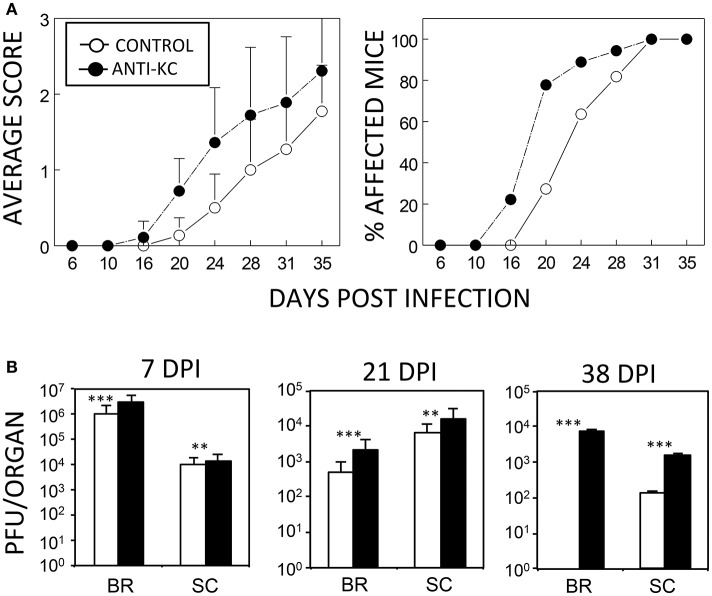
Development of TMEV-induced demyelinating disease in mice treated with anti-KC antibodies or control IgG. (A) Polyclonal rabbit anti-KC antibody or normal rabbit IgG (200 μg/mouse) was intraperitoneally administered into SJL mice (n = 18 and n = 11, respectively) at −1, 2, and 6 dpi with TMEV (1 × 106 pfu/mouse). The infected mice were graded for clinical signs as described in the Materials and Methods section. The results were expressed as average clinical scores and percentages of the affected animals at the indicated dpi. The two-tailed p-value of average clinical scores between the two groups based on the paired t-test during days 16 and 35 post infection was very significant (p < 0.0027). (B) Levels of viral loads in the CNS of TMEV-infected anti-KC antibody-treated mice (n = 3) and in the control IgG-treated mice (n = 3) were measured using the standard plaque assay at 7, 21, and 38 dpi. **p < 0.01; ***p < 0.001.